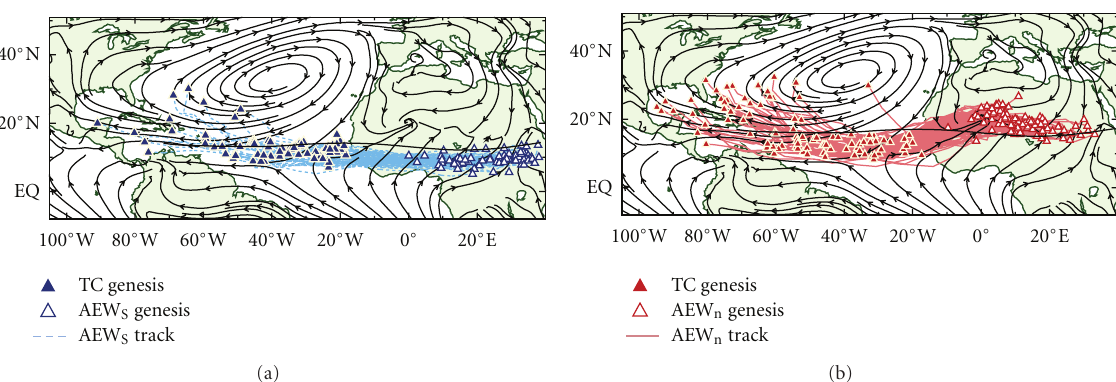
Figure 8: (Modified from Chen et al. [28]) July–September climatological streamlines at 925 mb overlaid with tropical cyclogeneses of AEW origin and the trajectory and genesis of AEWs for (a) the southern track (AEW S ) and (b) the northern track (AEW n ). Symbols are explained in the right. The AEJ core is indicated by the black solid line. Data period: